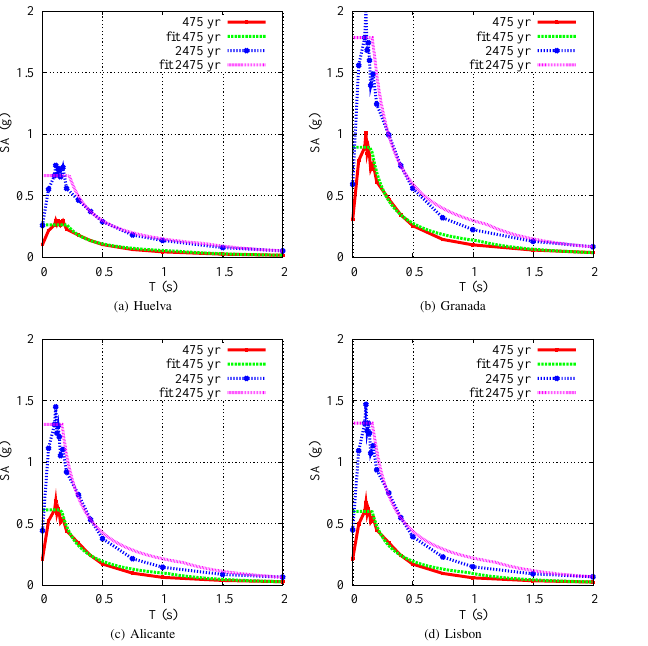
Fig.14. ComparisonofuniformhazardspectraandfittedcodespectraforcitiesinthesouthoftheIberianPeninsula: (a) Huelva; (b) Granada; Fig. 15. Comparison of uniform hazard spectra and fitted code spectra for cities in the north of the Iberian Peninsula: (a) Orense; (b) (c) Alicante; (d) Lisbon. Figure 14. Comparison of uniform hazard spectra and fitted code Pamplona; (c) Gerona; (d) Oporto. Figure 15. Comparison of uniform hazard spectra and fitted code spectra for cities in the north of the Iberian Peninsula: (a) Ourense, spectra for cities in the south of the Iberian Peninsula: (a) Huelva, (b) Pamplona, (c) Gerona, and (d) Porto. (b) Granada, (c) Alicante, and (d) Lisbon.